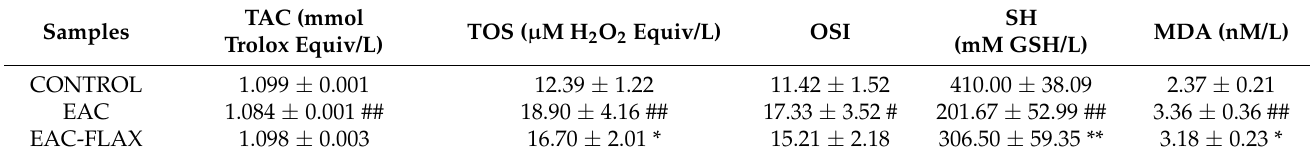
Table 5. Ascites oxidative stress markers at the end of the experiment.